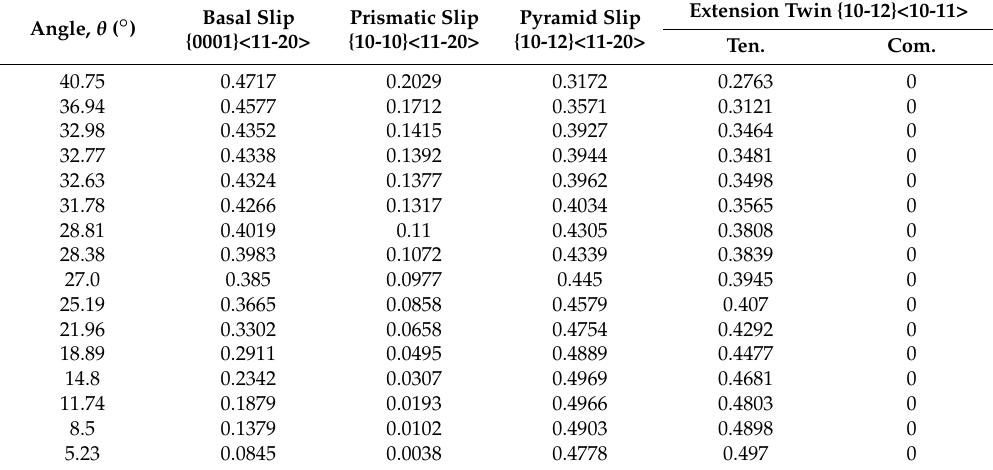
Table 3. Ideal Schmid factors, m , for basal slip, prismatic slip, pyramid slip and extension twin as a function of the angle, θ , between the c-axis of the grains and the extrusion direction